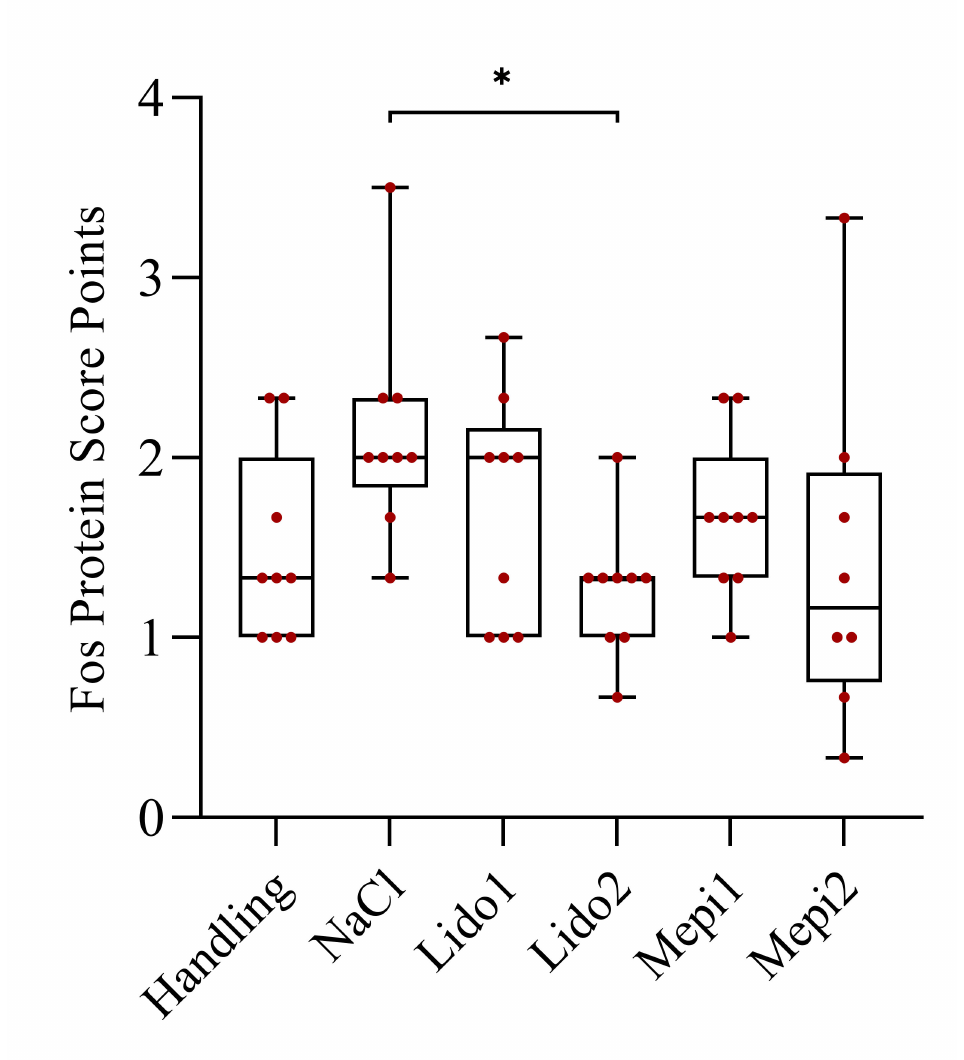
Figure 6. Fos protein expression in the lumbar and sacral segments of the spinal cord 90 min after castration. * p ≤